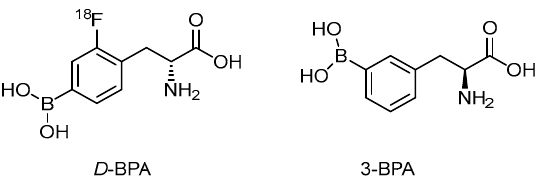
Figure 2. Structurally related BPA analogs as potential BNCT agents.